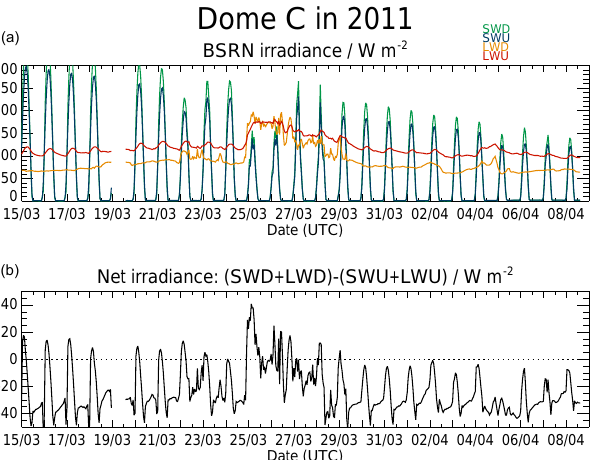
Figure 4. (a) Time evolution of downward short-wave radiation (SWD, green line), upward short-wave radiation (SWU, blue line), downward long-wave radiation (LWD, orange line) and upward long-wave radiation (LWU, red line) from 15 March to 8 April 2011 above Dome C as measured by the BSRN instruments. (b) Net ir- radiance (SWD + LWD − SWU − LWU) as measured by the BSRN instruments.